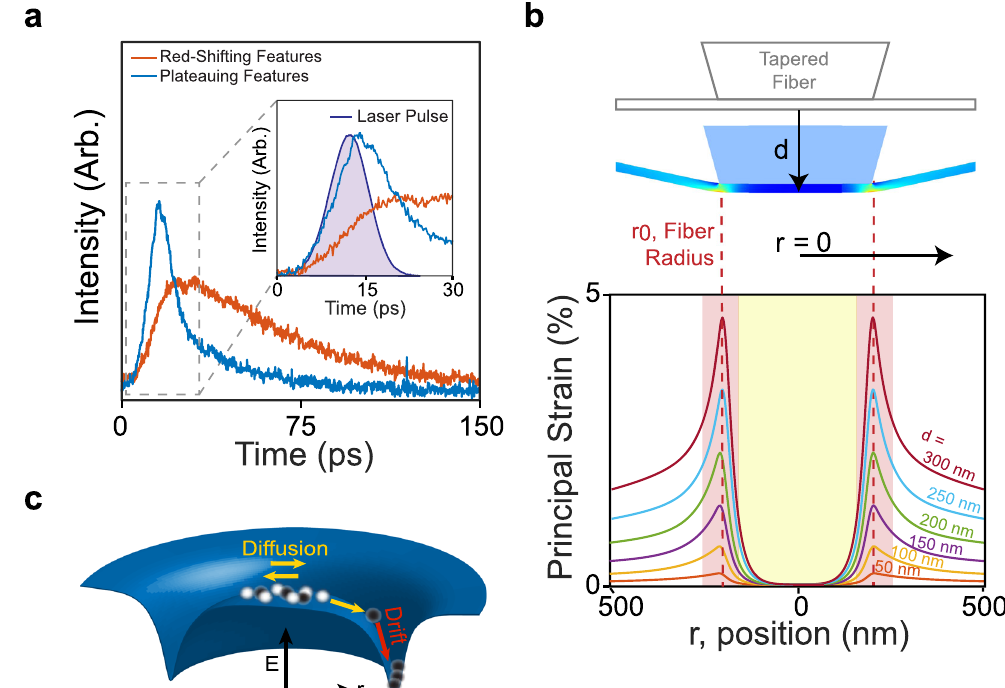
Fig. 4 Dark and bright exciton navigation across a local strain landscape. a Time-resolved PL from both the plateauing features and red-shifting features in device D4 reveal lifetimes associated with each set of 5.4 ± 0.2 and 48.2 ± 0.6 ps, respectively. Inset: Close up of the fi rst 30 ps of the time evolution, with the laser pulse shown. The red-shifted features have a ~10 ps delay relative to the plateauing features. b Finite element method modeling of strain in the hBN/WSe 2 /hBN heterostructure as it is displaced a distance d by the fi ber. The top part of the fi gure corresponds to d = 300 nm (strain of 5%). c Schematic of the strain-induced energy potential due to the fi ber facet (dark blue surface). Bright (white spheres) and dark (black spheres) excitons navigate this potential through a combination of diffusion (yellow arrows) and drift (red arrow); only dark excitons have a long enough lifetime to reach the energetic MoSe 2 monolayers may stem from the fact that the dark excitons are not the lowest energy excitonic state in that system, which provides an alternative explanation to that proposed in some theoretical works 32 . Finally, the ability to create energetic traps hundreds of meV deep via strain coupled with the long lifetime of dark excitons indicates a potential route for creating dark exciton condensates in a monolayer semiconductor 33,34 .